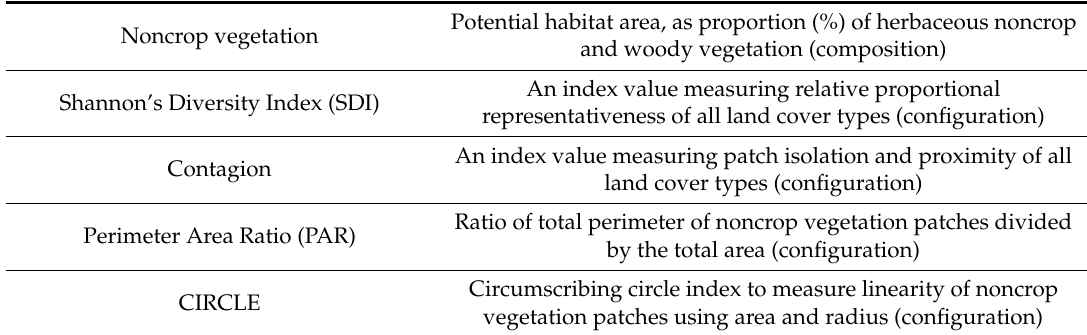
Table 1. List of landscape indicators tested for association with vocalizing bird richness. Noncrop vegetation